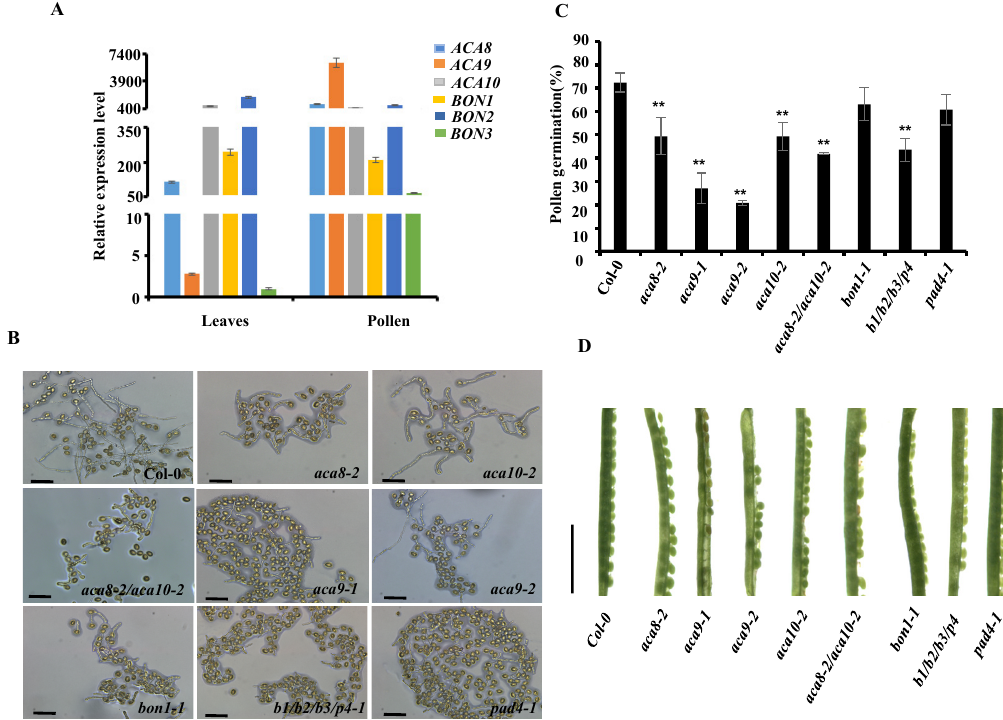
Figure 2. The mutation in ACAs and BONs affect pollen germination. ( A ). Expression levels of ACA8/9/10 and BON1/2/3 in leaves and pollens. ( B ). The phenotype of pollen germination in wild type Col-0 and indicated genotypes (scale bars: 50 µ m); ( C ). The pollen germination ratio in various genotypes. The average germination rate was generated from three biological replicates, each replicate with more than 300 pollens. Genotypes: b1 / b2 / b3/p4 = bon1-1 / bon2-2 / bon3-3/pad4-1 . ** represents significant differences compared to WT ( p < 0.01). ( D ). Seed setting was affected in aca and bon mutants (scale bar 0.5